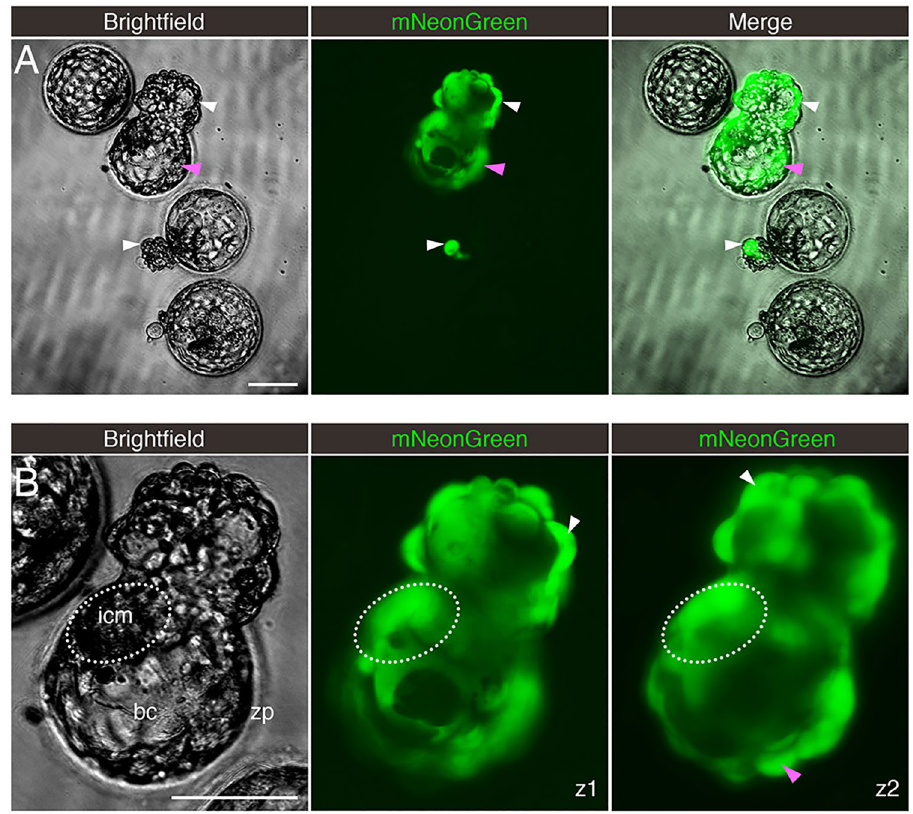
Figure 4. Embryos Exposed to Live SARS-CoV-2 are Susceptible to Infection. Fluorescent signal indicates cells infected with icSARS-CoV-2-mNeonGreen. ( A ) Four sample blastocysts exposed to the virus. One blastocyst has not initiated hatching and shows no evidence of infection, two blastocysts are at early stages of hatching (one shows evidence of infection in the herniating cells), and one blastocyst is in advanced hatching phase showing high incidence of infected cells. ( B ) High magnification of blastocyst with high incidence of positive cells, with two panels showing the mNeonGreen channel at different focus depths (z-axis). White arrowheads point to positive herniating cells in hatching blastocysts, pink arrowhead points to positive cells in the zona pellucida compartment of a hatching blastocyst. Representative images from independent biological replicates (n = 19